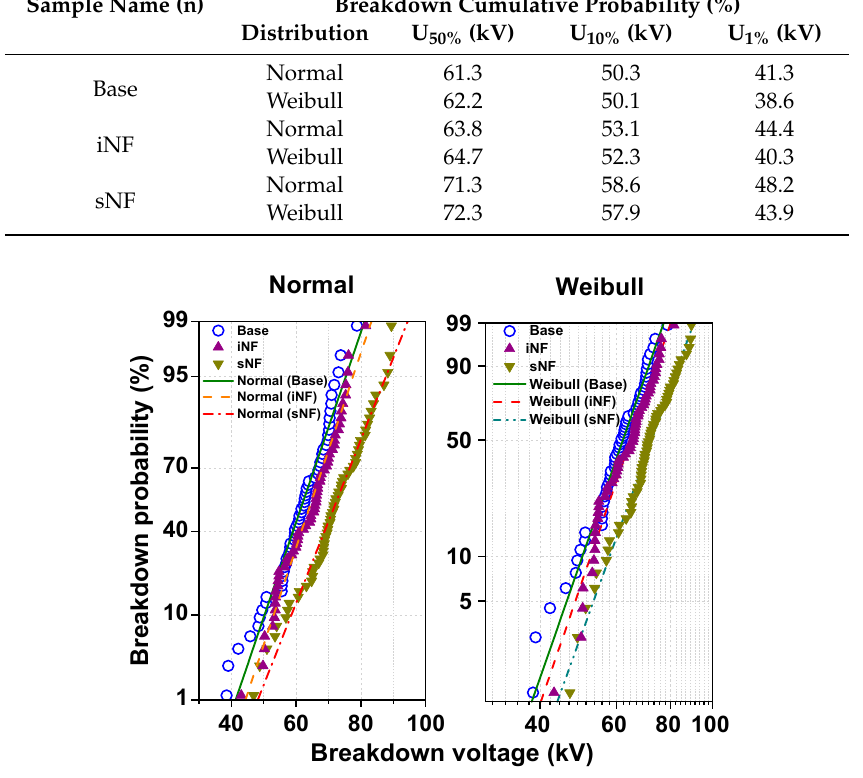
Figure 7. Probability density plots of the breakdown events for each sample in question according to Normal and Weibull distributions.